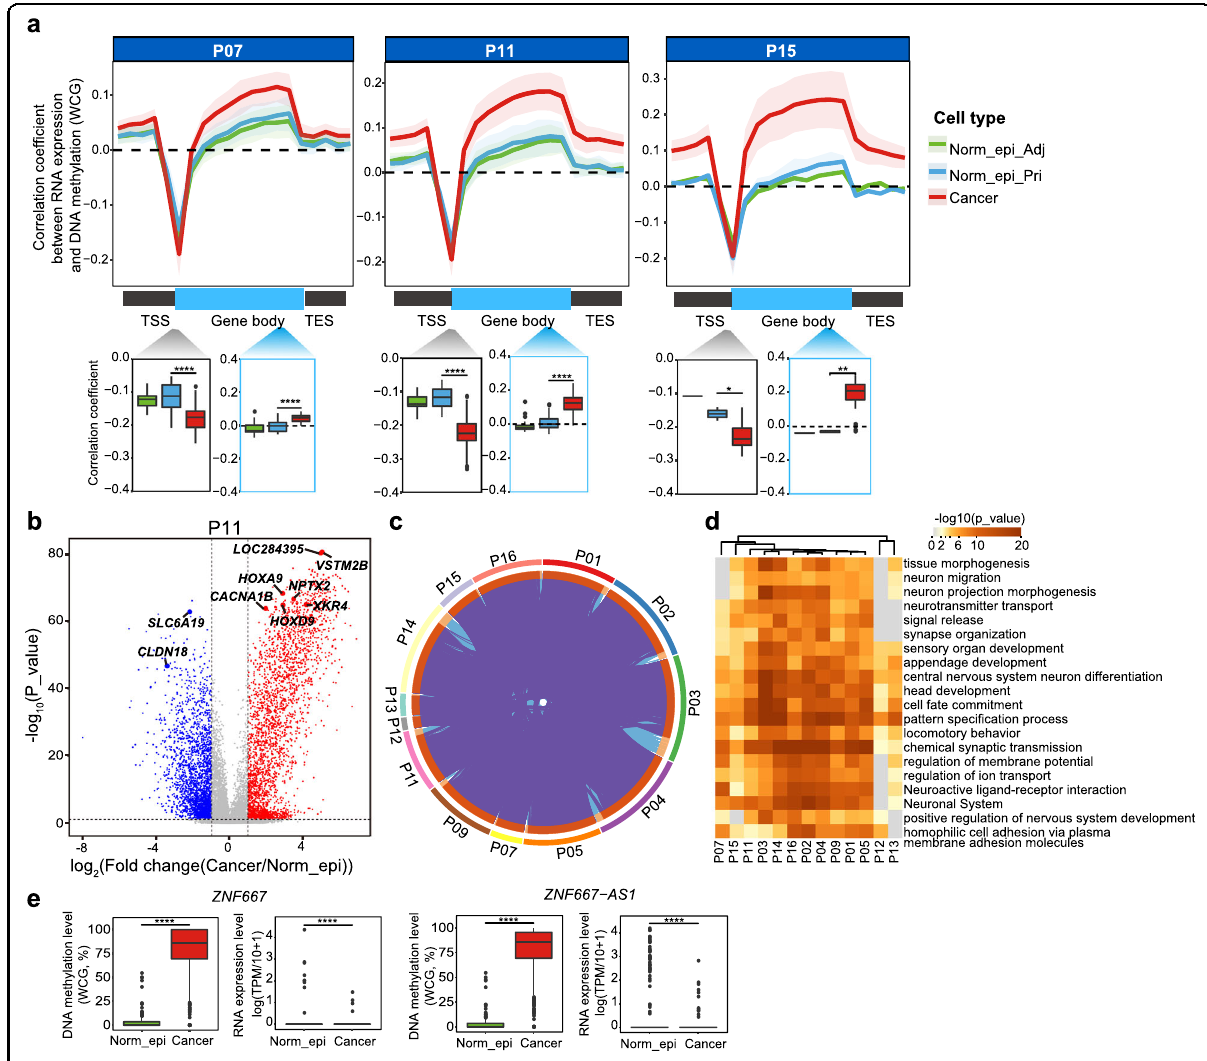
Fig. 2 DNA methylation shows a stronger correlation with RNA expression in cancer cells. a Spearman correlations between DNA methylation levels across gene bodies (including 15 kb fl anking regions) and corresponding RNA expression levels in each cell type in representative patients. The boxplots at the bottom show the statistical test results between cancer cells and Norm_epi cells using the Wilcoxon rank-sum test. The promoter regions are from – 1 to + 0.5 kb around the transcription start site (TSS), and the gene body regions are + 2 kb from the TSS to the transcription end site (TES). * P < 0.05; ** P < 0.01; **** P < 0.0001. b Cancer cells have more genes with increased promoter DNA methylation. Representative genes across multiple patients are labeled. c Overlap of higher methylated promoters across all patients. The purple lines indicate shared genes, and the blue lines represent the same Gene Ontology terms. d Heatmap showing the top enriched biological terms of the cancer cell hypermethylated promoters in each patient. e Example genes show a reversed pattern between the promoter DNA methylation level and RNA expression level. The statistical test was carried out using the Wilcoxon rank-sum test. **** P <